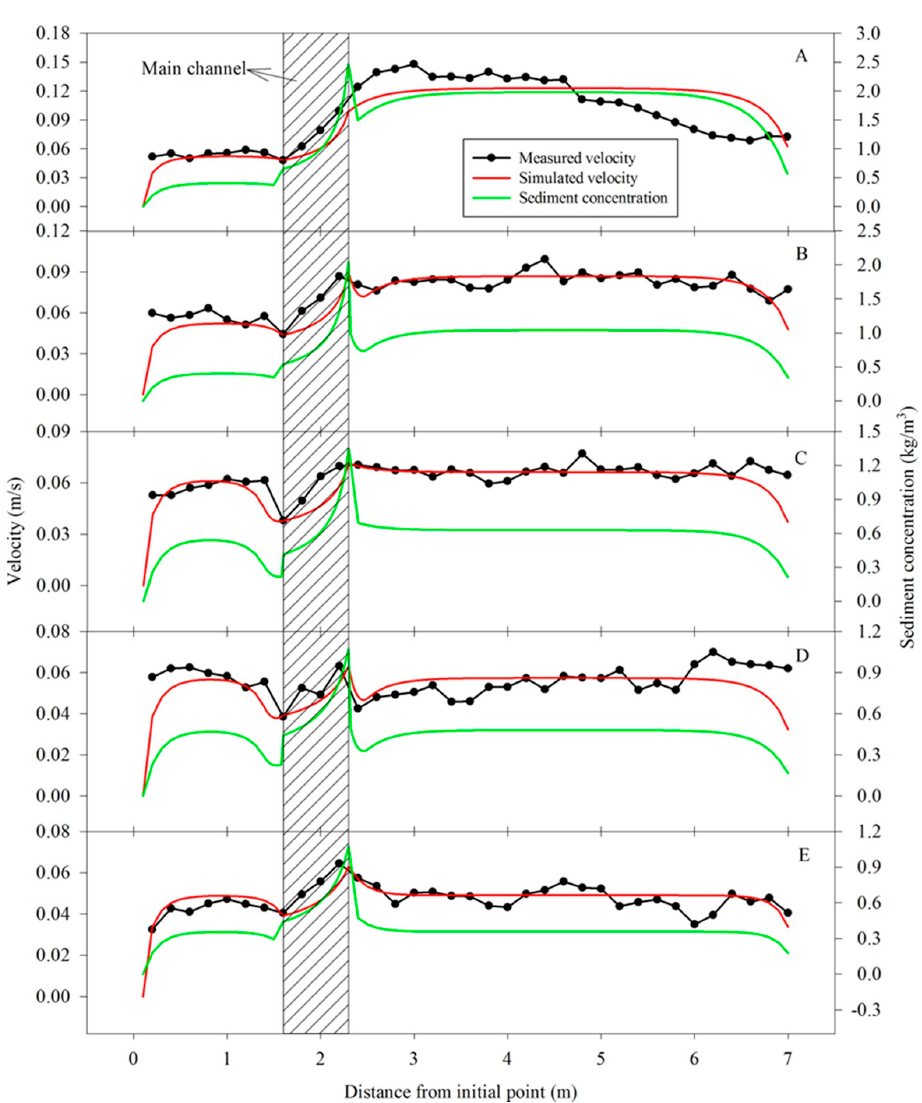
Figure 4. Velocity at the curved top of the curved compound rectangular channel and a comparison chart of the transverse distributions of sediment concentration. ( A ), curved compound channel with non-vegetation on the beach; ( B ), curved compound channel with vegetation on the convex bank of the beach; ( C ), curved compound channel with vegetation on the concave bank of the beach; ( D ), curved compound channel with vegetation on both sides of the beach; and ( E ), curved compound channel full of vegetation on the beach.